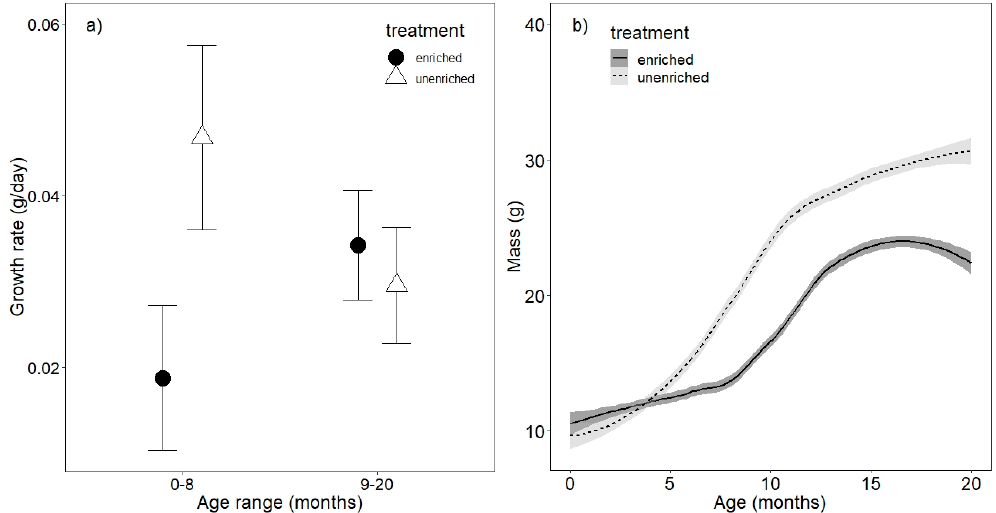
Figure 2 . ( a ) Growth rates (g/day) of enriched and unenriched eastern box turtles ( Terrapene carolina ) during captive-rearing. Thirty-two turtles (16 in each treatment) were raised for eight months. Twenty turtles (10 in each treatment) were kept in captivity for an additional year. Symbols represent means and bars are 95% confidence intervals. ( b ) Mass (g) of enriched and unenriched turtles during captive- rearing. Lines are means fit by loess smoothing, and ribbons represent 95% confidence